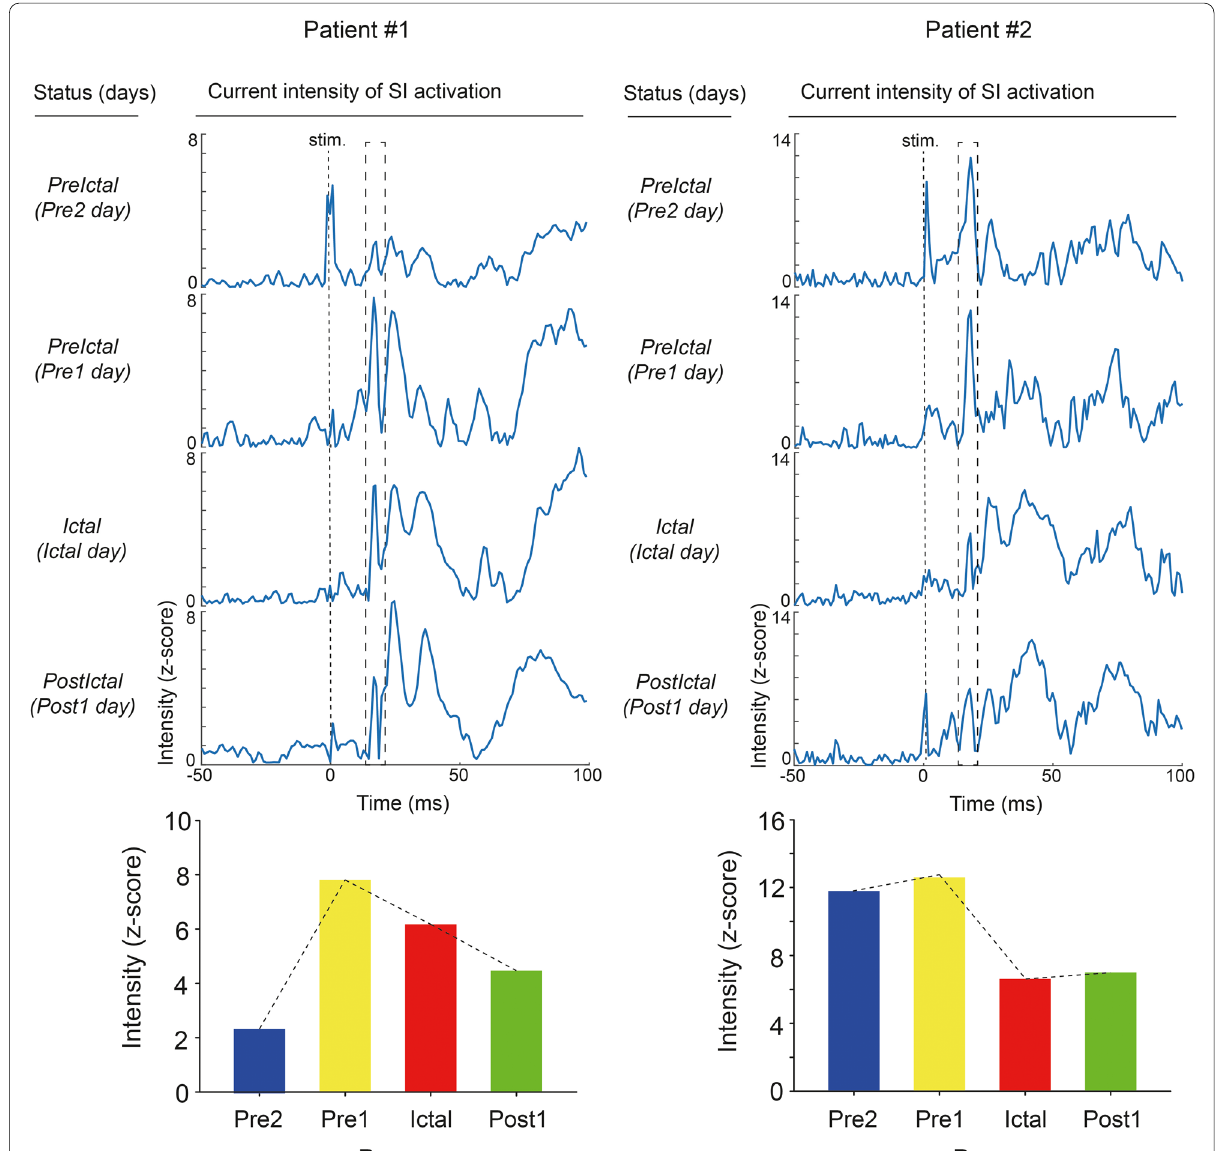
Fig. 4 Evoked current intensity of S1 activation during migraine cycle. Top: S1 current intensity over time ( migraine cycle for patient 1 and patient 2. Bottom: Peak S1 activation during migraine cycle. S1, primary somatosensory cortex; Pre2 , 24–48 h before headache onset; Pre1 , within 24 h after headache onset; Ictal , during migraine attack; Post1 , within 24 h after headache